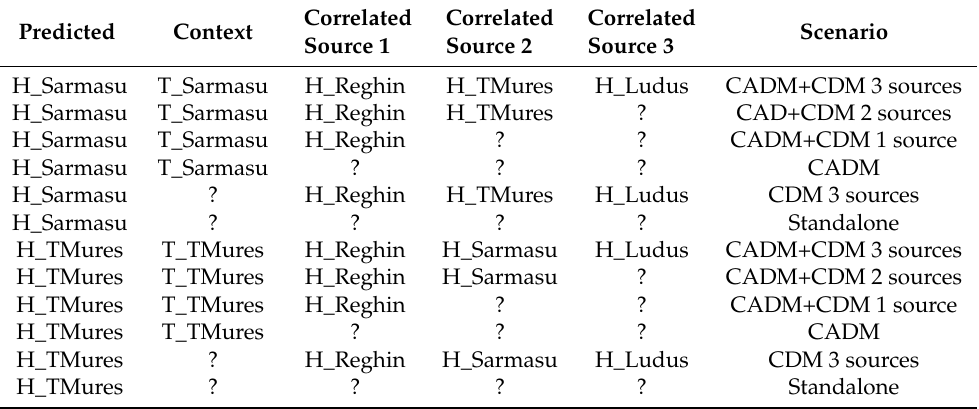
Table 6. Example of combined test scenarios used in the experiments. Notations: H_Location and T_Location denotes the humidity (H) and respectively the temperature (T) of the specified location.